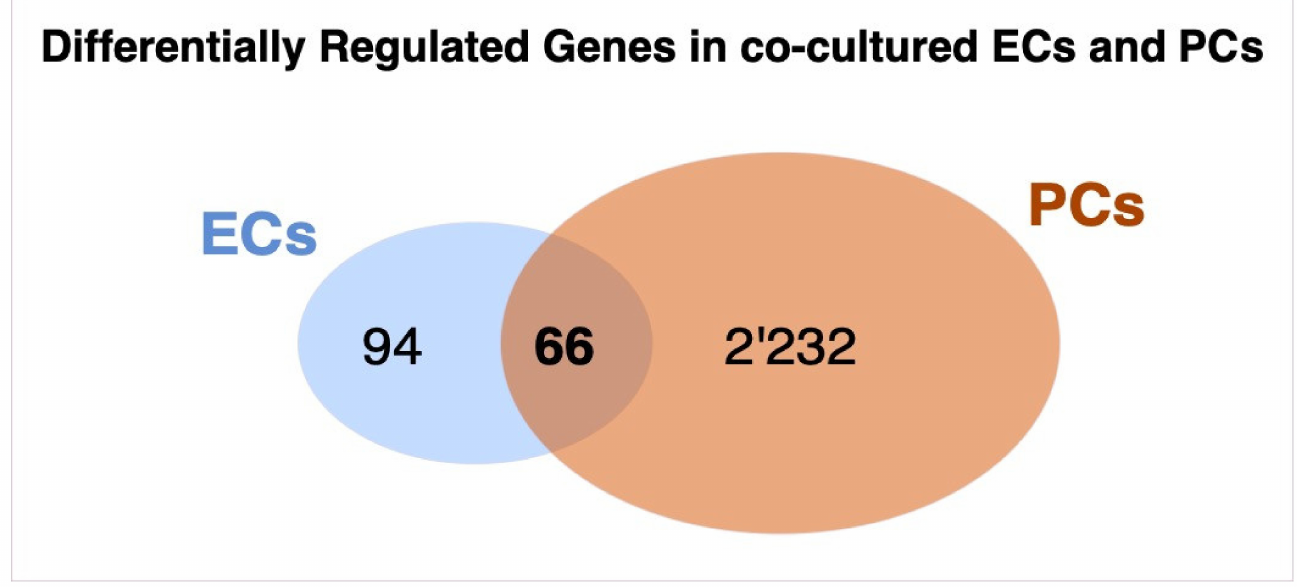
Figure 6. Venn diagram of differentially regulated genes (DRGs) between co-cultured endothelial cells (ECs) and pericytes (PCs). ECs and PCs were cultured alone or together in co-culture on permeable Transwell inserts for 7 days, before they were lysed for RNA extraction and micro-array analysis. A total of 160 DRGs were observed in co- vs. mono-cultured ECs, while co- vs. mono-cultured PCs the number of DRGs was 2298. A total of 66 genes were common in both comparisons. Comparison of gene expression data of co-cultures versus mono-cultures of each cell-type in triplicates was performed by using Transcriptome Analysis Console (TAC, Applied Biosystems). For the analysis, a fold change (FC) cut-off of 1.5 ( ≈ log2FC +/ − 0.59) and FDR p -Value of 0.05 was